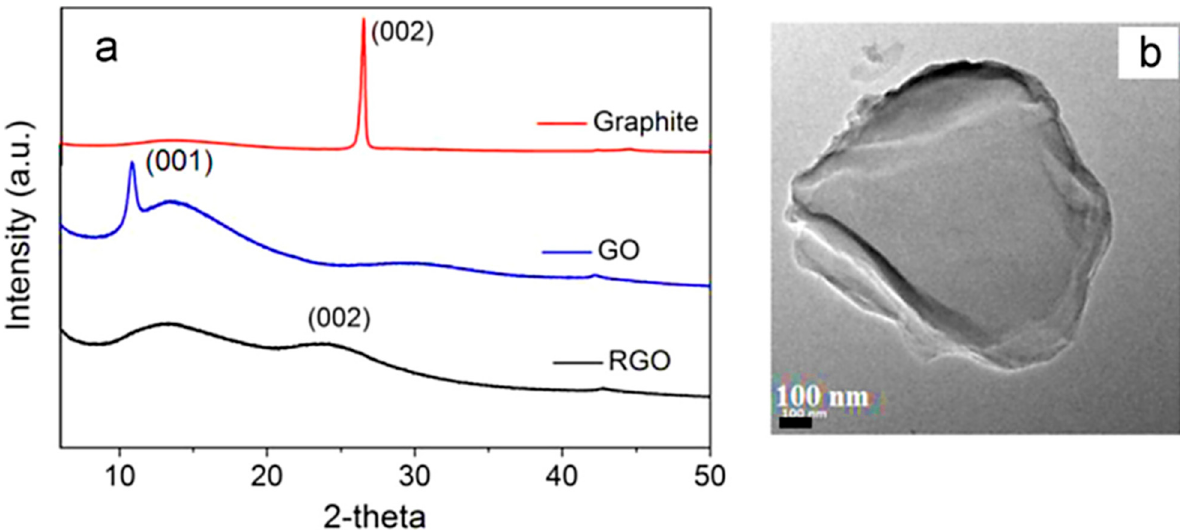
Figure 4. ( a ) X-ray diffraction of graphite, GO, and RGO and ( b ) TEM image of RGO sample [81]. GO = graphene oxide; RGO = reduced graphene oxide; TEM = transmission electron microscopy. Reproduced with permission from Elsevier.